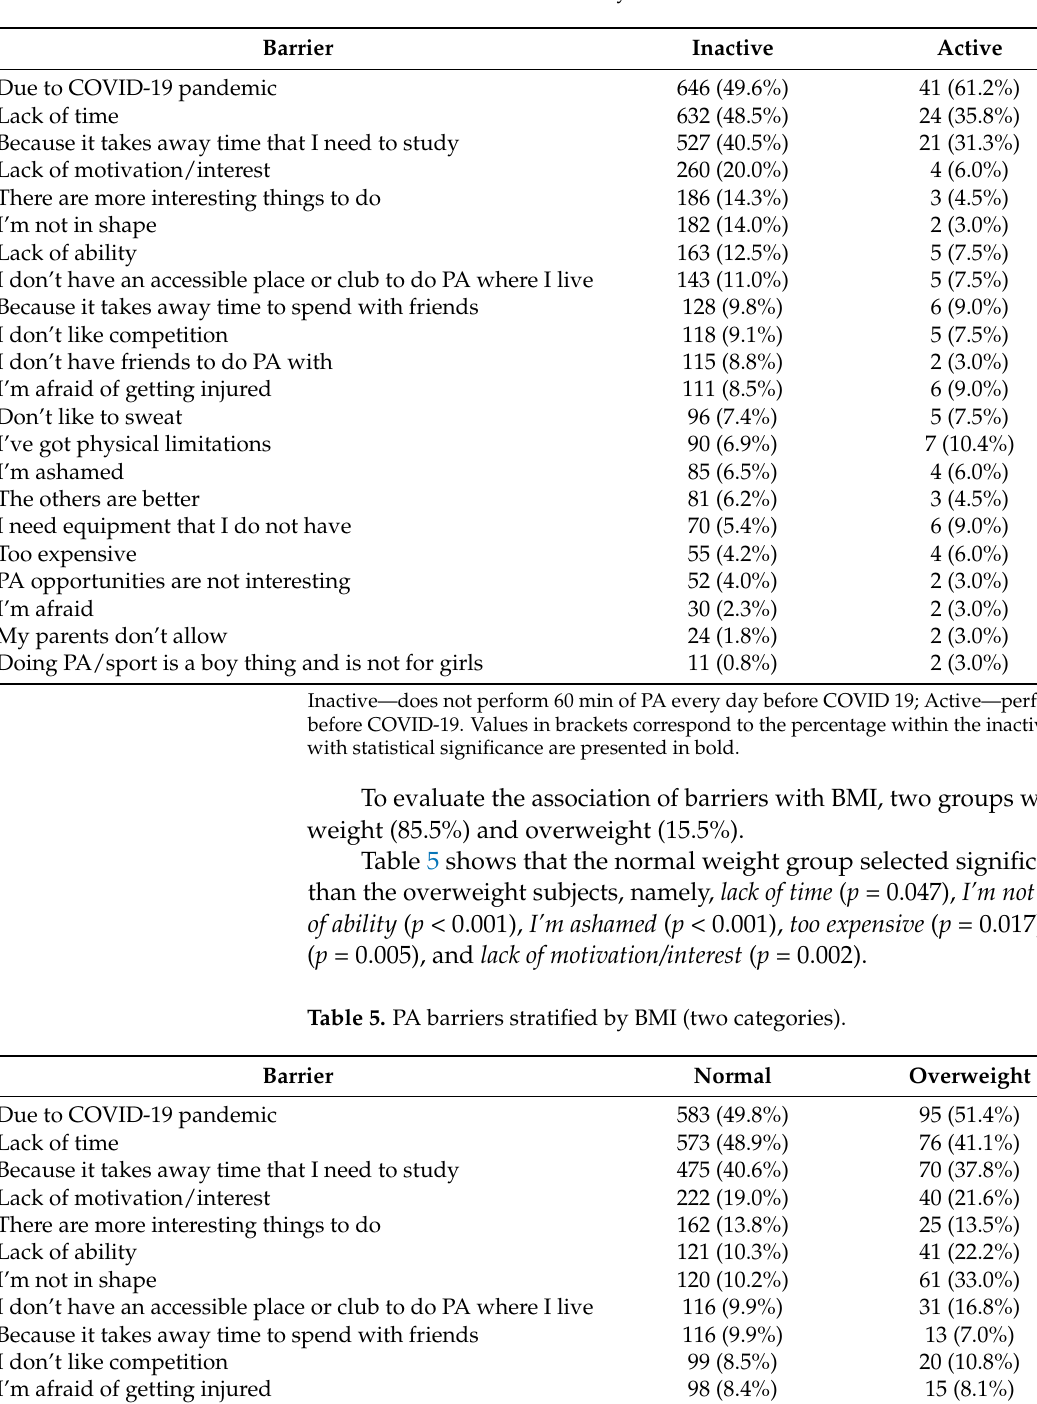
Table 4. PA barriers stratified by inactive and active students.